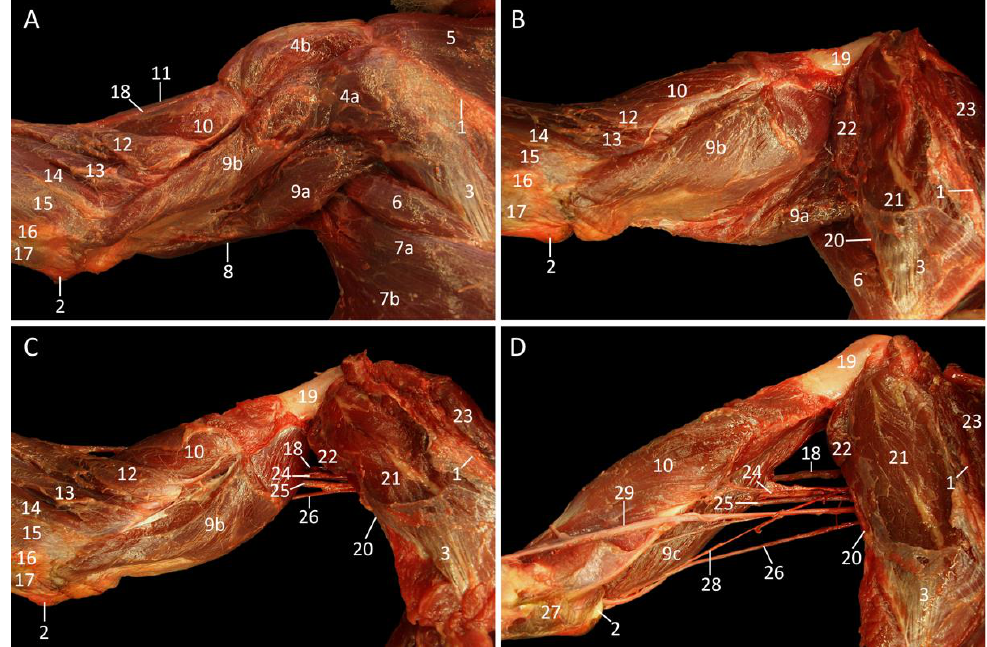
Figure 6. Lateral view of the left upper arm; the arterial system is filled with red latex. ( A ): Superficial layer; ( B ): Second layer, after the m. trapezius pars cervicalis, the m. biceps brachii caput longum, the m. spinodeltoideus, the m. acromiodeltoideus, and the m. tensor fasciae antebrachii have been taken away; ( C ): Third layer, with subsequent removal of the m. triceps brachii caput longum and the m. teres major; ( D ): Deepest layer, after amputation of the m. triceps brachii caput laterale, the m. brachioradialis, the m. extensor carpi radialis longus, the m. extensor carpi radialis brevis, the m. extensor digitorum communis, the m. extensor digitorum quarti et quinti proprius, and the m. extensor carpi ulnaris.